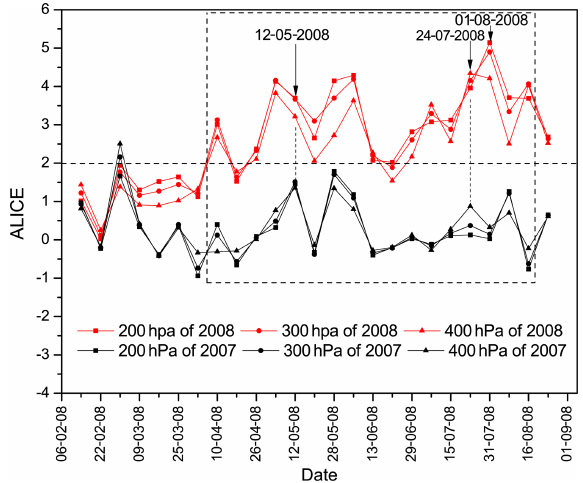
Figure 13. Comparison of the average ALICE index from 2007 and